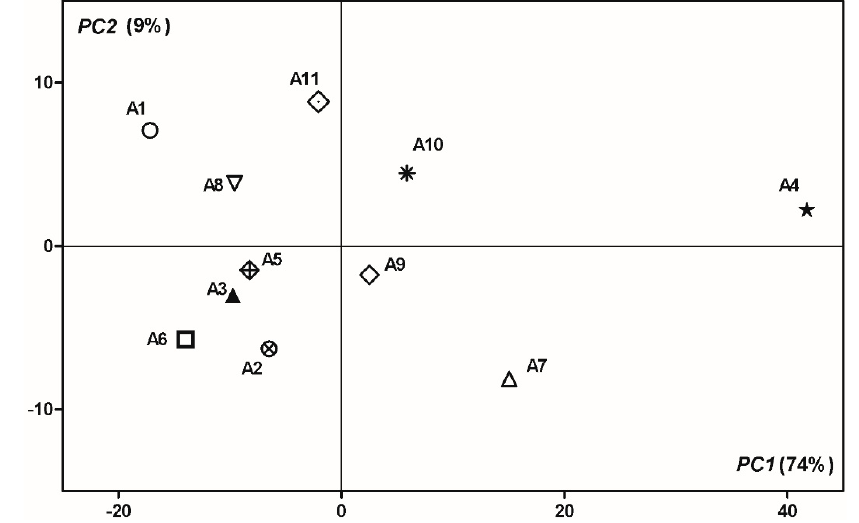
Figure 4. Principal components analysis bi-plots of 11 apricots cultivars based on their carotenoids content and fatty acids profiles. The first two components together explain 83% of the data